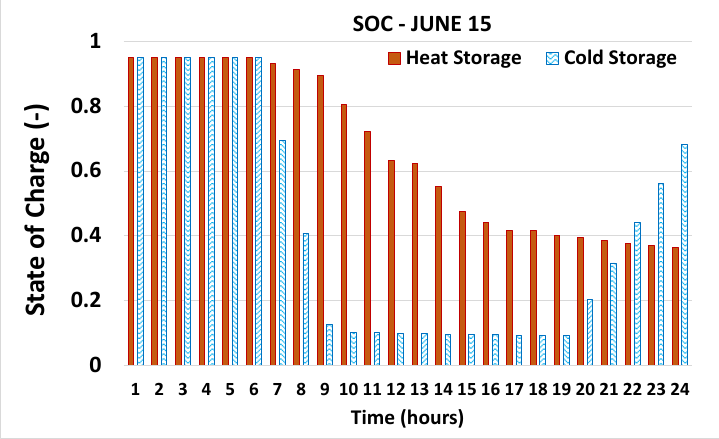
Figure 13. State of charge of the heat storage and cold storage during the representative day.